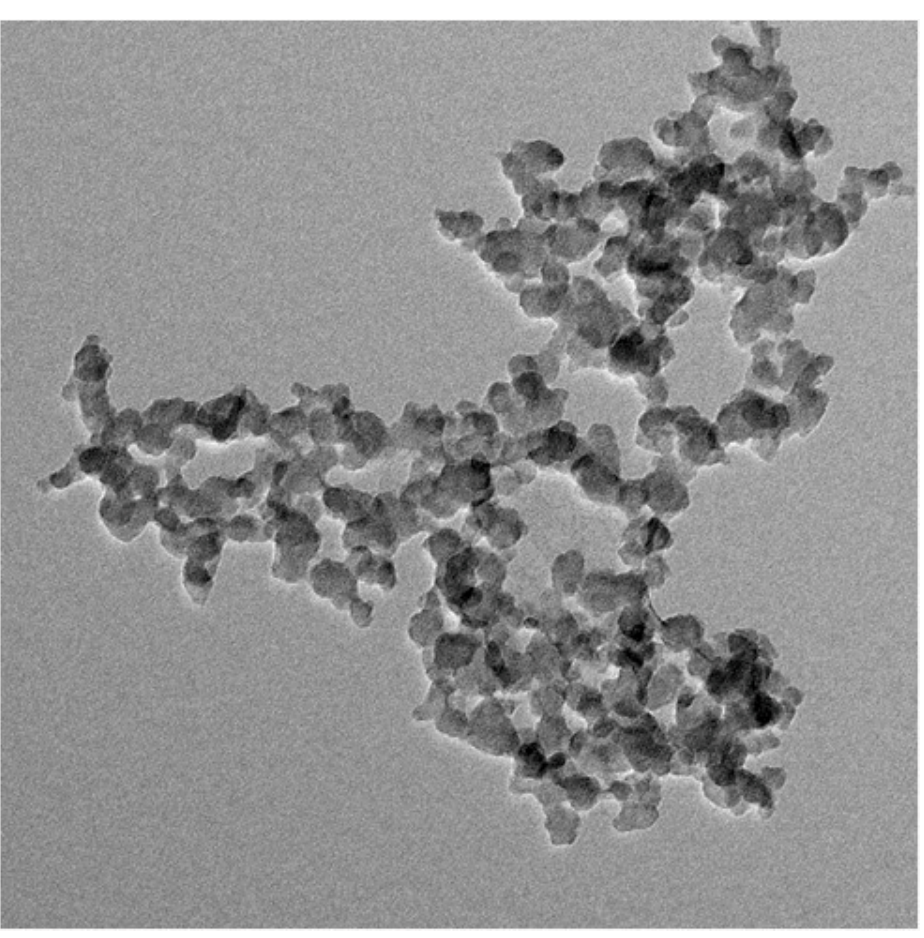
Figure 6. TEM analysis showing different sizes of Cu-Mn bimetallic nanoparticles with an average particle size of 50 nm. Scale bar indicates 100